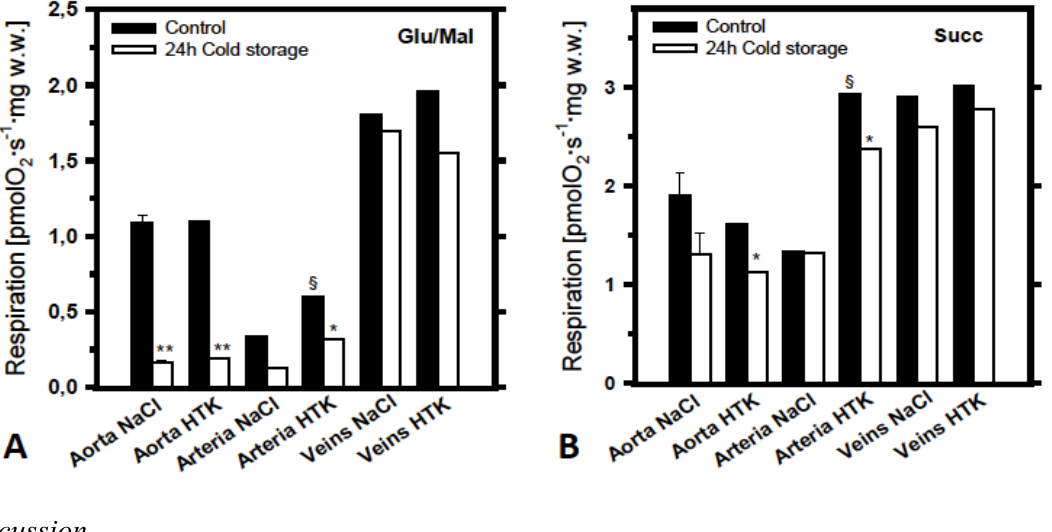
Figure 2. Respiratory activities of mitochondria in permeabilized aorta, arterial or venous fibers (cryopreserved in DMSO containing preservation solution, see reference